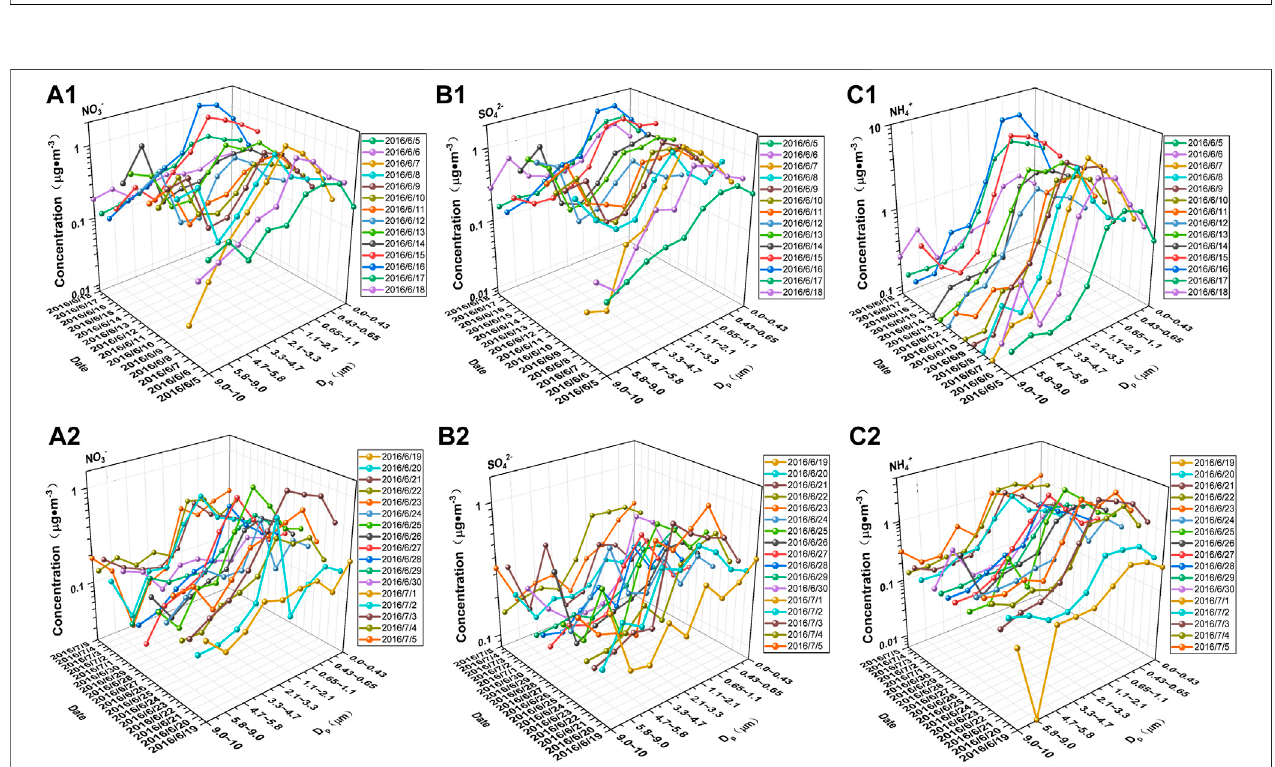
FIGURE 7 | Daily variations in spectral distribution of water-soluble inorganic (a1, a2) NO 3 − (b1, b2) SO 42 − and (c1, c2) NH 4+ at different period.